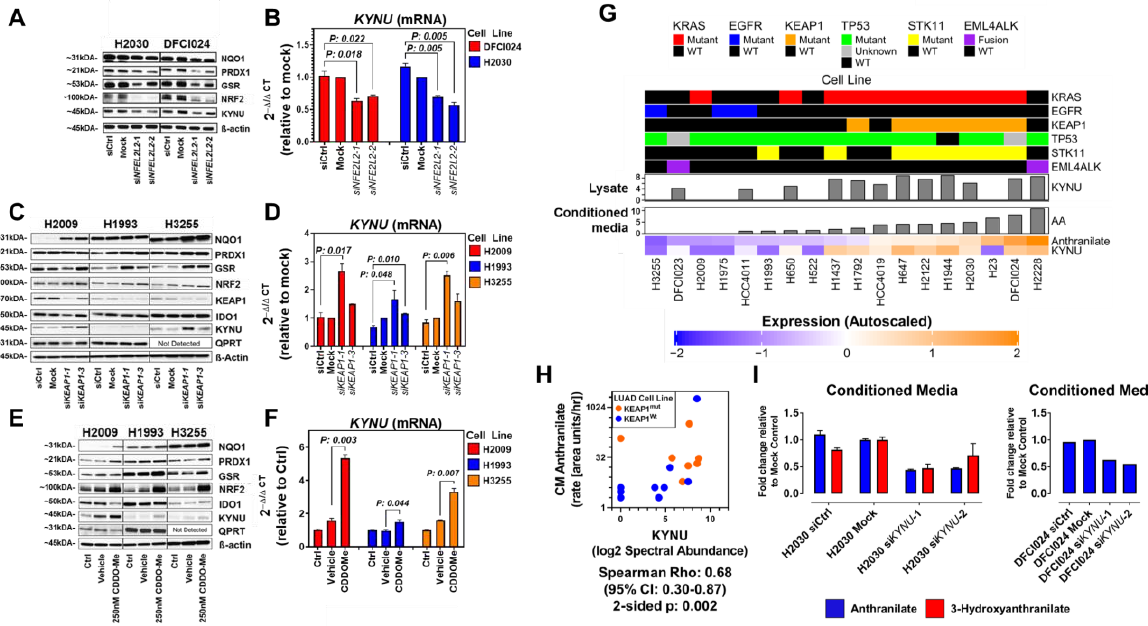
Figure 2. KYNU is regulated by NRF2 activation in lung adenocarcinomas and is functionally active. ( A ) Immunoblots for KYNU, NRF2 and NRF2-regulated enzymes peroxiredoxin 1 (PRDX1), glutathione reductase (GSR), and NAD(P)H quinone dehydrogenase 1 (NQO1) in KEAP1/KRAS mutant adenocarcinoma cell lines DFCI024 and H2030 following siRNA-mediated knockdown of the NRF2 transcribing gene NFE2L2 . ( B ) mRNA expression (2 − ∆∆ Ct ) of KYNU following siRNA-mediated knockdown of NFE2L2 in KEAP1/KRAS mutant adenocarcinoma cell lines DFCI024 and H2030. ( C ) Immunoblots for IDO1, KYNU, QPRT, KEAP1, NRF2, and NRF2-regulated enzymes PRDX1, GSR, and NQO1 following siRNA-mediated knockdown of KEAP1 in H2009 (m KRAS ), H1993 ( KRAS/EGFR wild-type), and H3255 (m EGFR ). ( D ) mRNA expression (2 − ∆∆ Ct ) of KYNU following siRNA-mediated knockdown of KEAP1 in H2009, H1993, and H3255. ( E ) Immunoblots for IDO1, KYNU, QPRT, NRF2, and NRF2-regulated enzymes PRDX1, GSR, and NQO1 following 48-h treatment of H2009, H1993, and H3255 with NRF2-activator CDDOMe, vehicle (DMSO) or control media. ( F ) mRNA expression (2 − Ct ) of KYNU following 48-h treatment of H2009 (m KRAS ), H1993 ( KRAS/EGFR wild-type), and H3255 (m EGFR ) with CDDOMe, vehicle or control media. CDDOMe: 2-Cyano-3,12-dioxo-oleana-1,9(11)-dien-28-oic acid methyl ester. ( G ) Heatmap illustrating the overall representation of whole lysate protein levels of KYNU and rates of anthranilate accumulation in conditioned media (CM) of 18 LUAD cell lines. Bar plots represent spectral abundance (log2) of KYNU and rate (log2 area units per hour per 500 µ g of protein) of anthranilate accumulation in conditioned media. Columns were ranked from by rate of anthranilate accumulation in CM from lowest to highest. ( H ) Scatter plot illustrating the association between whole lysate protein levels of KYNU and rates of anthranilate accumulation in conditioned media (CM) of 18 LUAD cell lines. Nodes represent whether the respective cell line was wild-type (wt; blue) or mutant (mut; orange) for KEAP1 . ( I ) Conditioned media abundance of anthranilate and 3-hydroxyanthranilate following siRNA-mediated knockdown of KYNU in KEAP1/KRAS mutant LUAD cell lines H2030 and